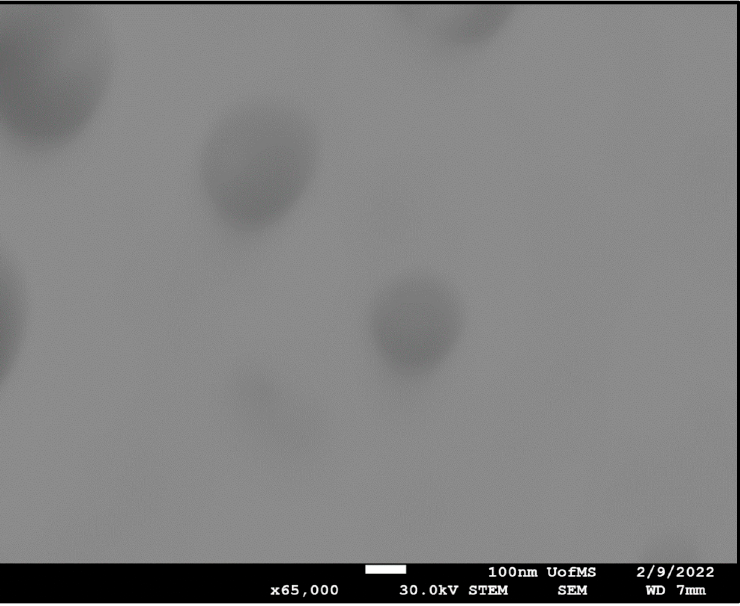
Figure 2. Scanning transmission electron micrograph of F10 formulation at ×65 k magnification.